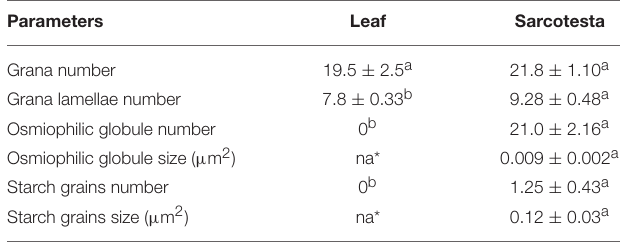
TABLE 4 | Changes in Torreya grandis cv. “Merrillii” seed oil composition caused by treatment with 3-(3,4-dichlorophenyl)-1,1-dimethylurea (DCMU) in